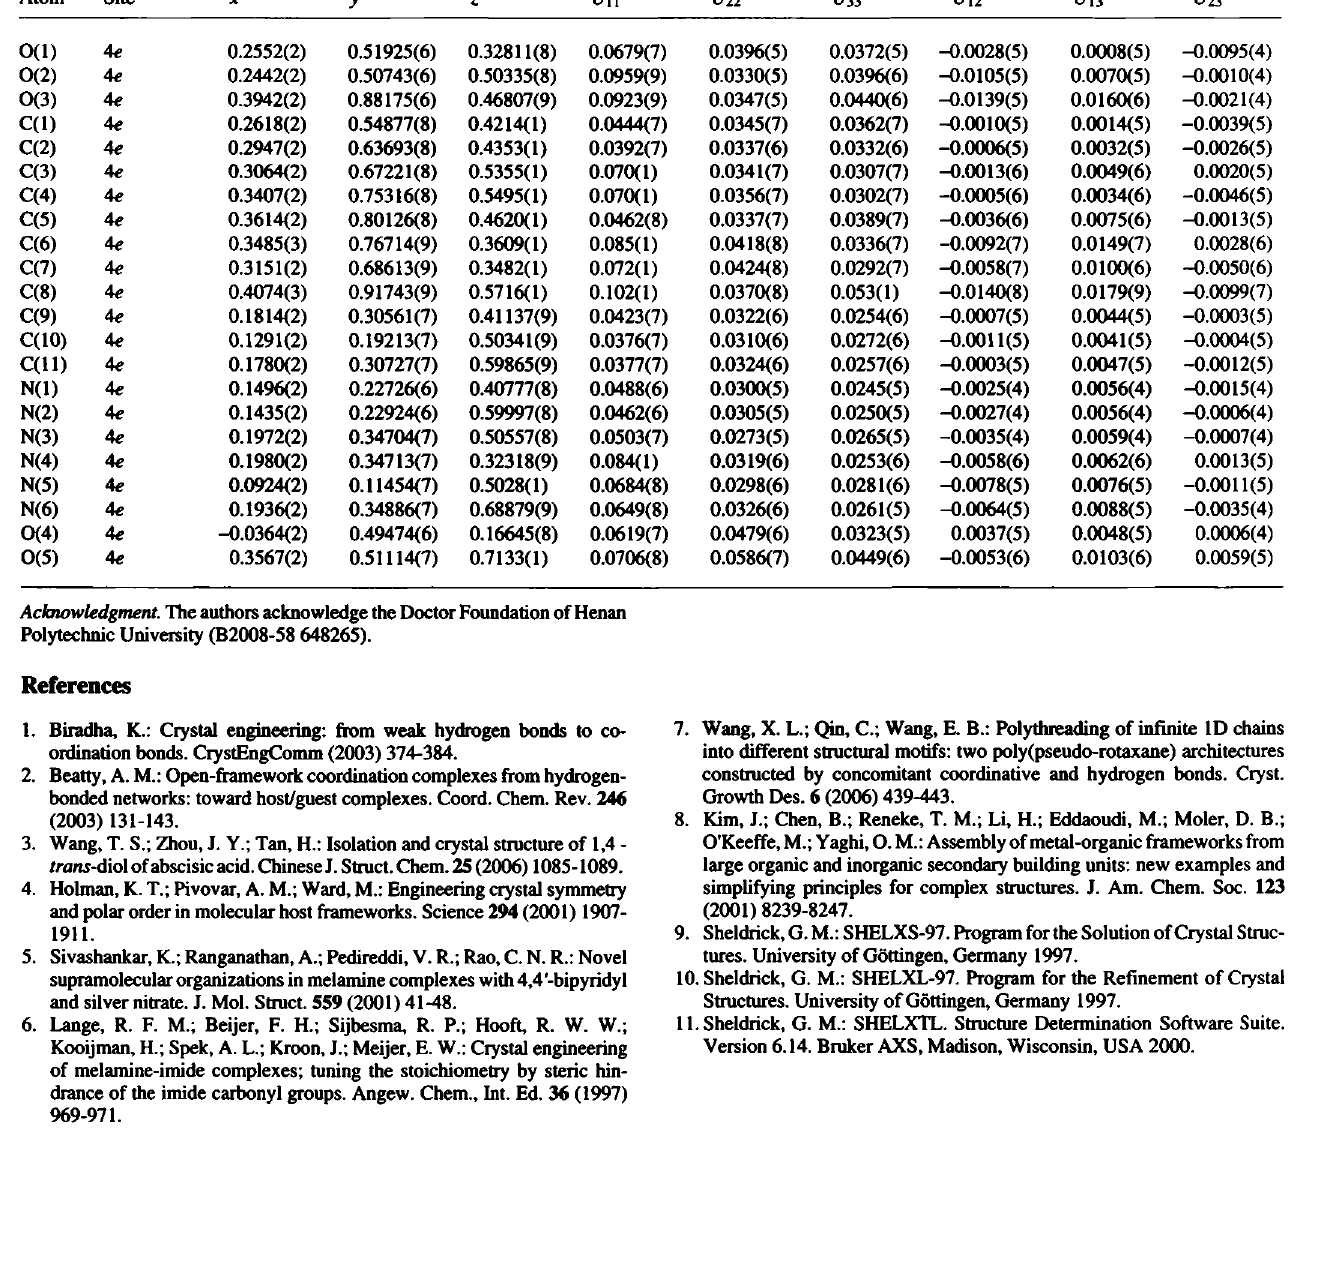
Table 3. Atomic coordinates and displacement parameters (in Â 2